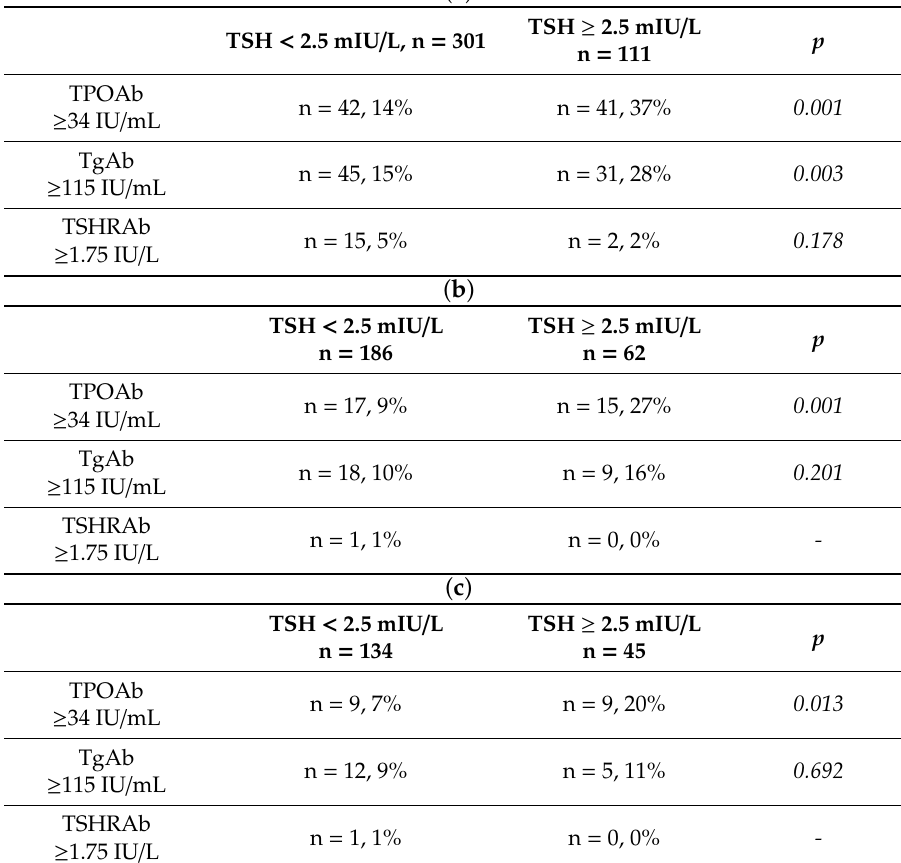
Table 2. Percentage of abnormal values of thyroid antibodies in patients with TSH < 2.5 mIU / L and in patients with TSH ≥ 2.5 mIU / L, evaluated in the whole group of 466 inpatients ( a ), in the group of 280 inpatients with normal thyroid tests ( b ) or in the group of 240 inpatients (after excluding 40 patients on L-thyroxine treatment) ( c ). Statistical evaluation was performed by the two-sided ratio comparison test. Statistical significance was determined at the level of p < 0.05. The level of statistical significance is given in